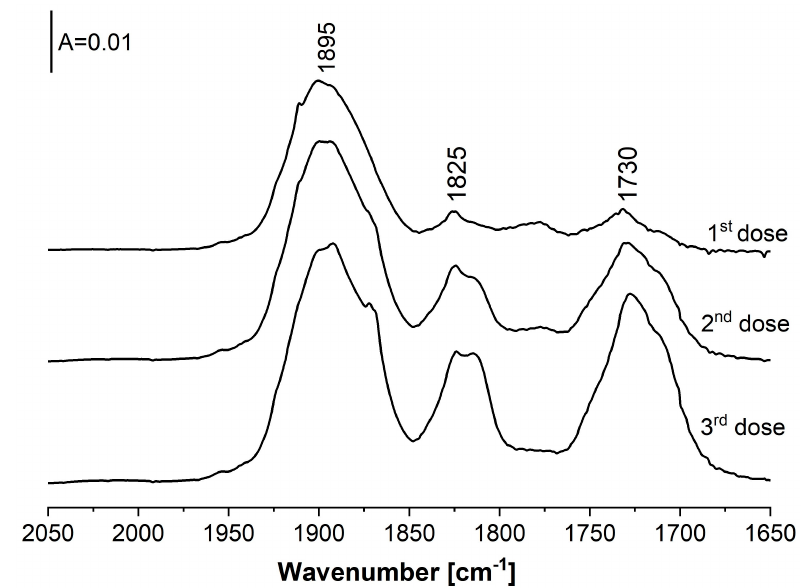
Figure 8. The spectra recorded upon the sorption of increasing amounts of NO at 170 K in zeolite Cu(5)NaFAU.